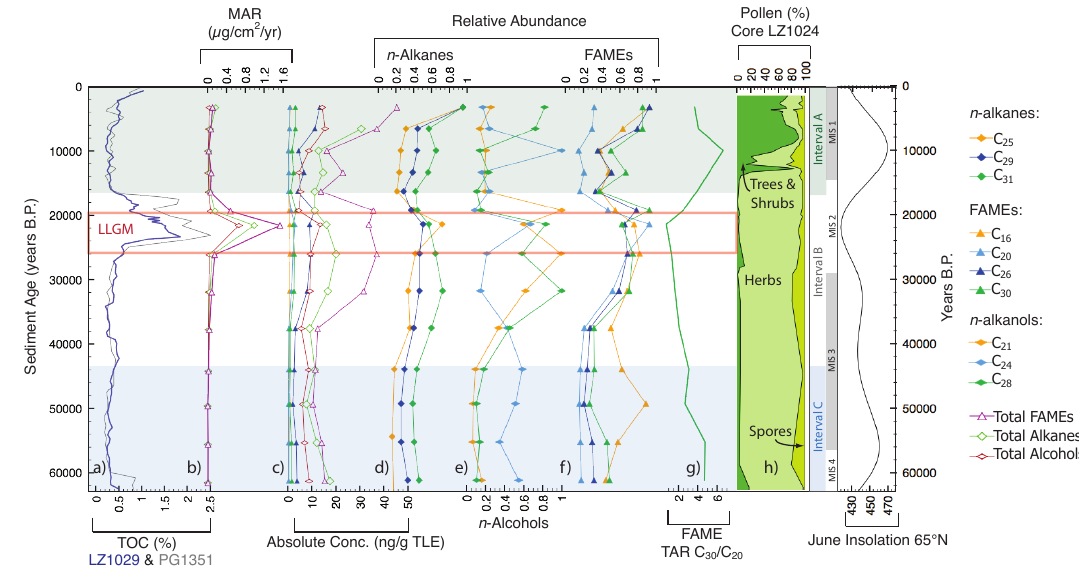
Fig. 2. Concentrations of n -alkanes, FAMEs and n -alkanols relative to TOC. Compound concentrations are represented in various con- figurations: (a) TOC content for both cores PG1351 (grey) and LZ1029 (blue), (b) mass accumulation rates of major compound groups, (c) absolute concentrations of representative FAMEs and total n -alkanols, n -alkanes, and FAMEs. Relative abundances of n -alkanes, n - alkanols, and FAMEs are plotted in (d) , (e) , and (f) , respectively. (g) FAME terrigenous-aquatic ratio based on the C 30 and C 20 FAMEs, and (h) pollen data from nearby core LZ1024 (Lozhkin et al., 2007). Summer insolation at 65 ◦ N is shown (Berger and Loutre, 1991). The orange box denotes